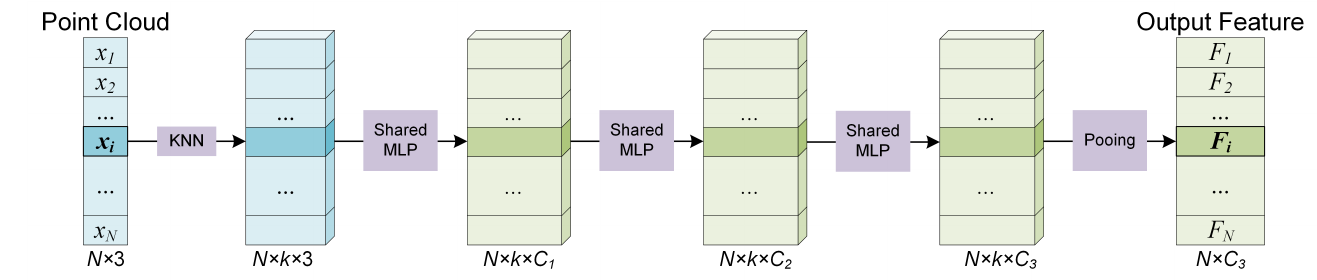
Figure 3. The module for extracting local features based on